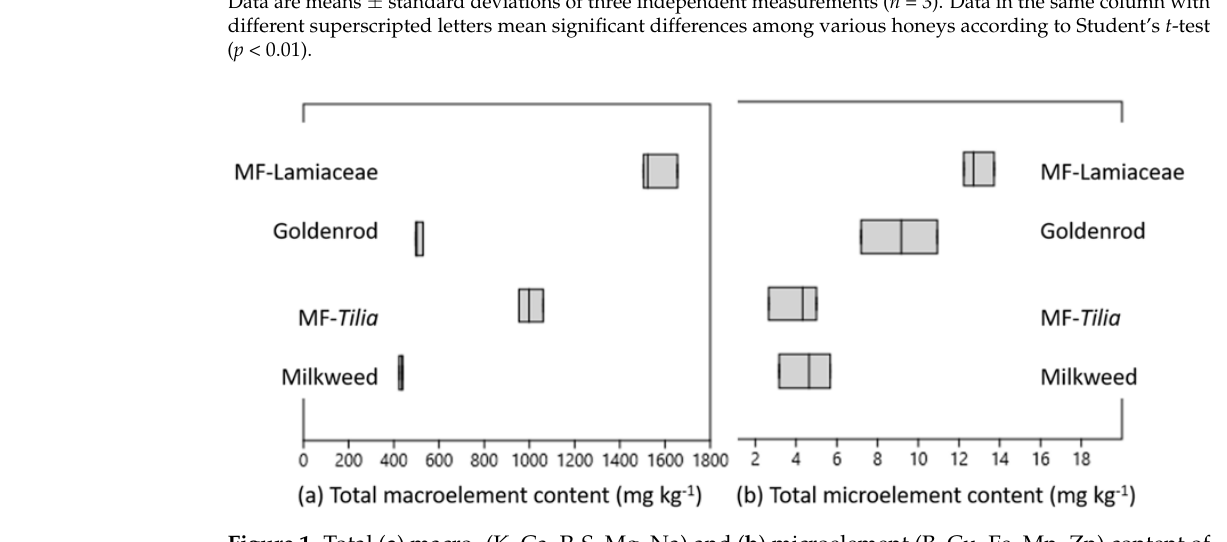
Figure 1. Total ( a ) macro- (K, Ca, P, S, Mg, Na) and ( b ) microelement (B, Cu, Fe, Mn, Zn) content of the honeys studied.There were also significant differences between the K content of uni ‐ and multi ‐ floral honeys, and even between that of the multifloral honeys. MF ‐ Tilia and MF ‐ Lamiaceae honeys